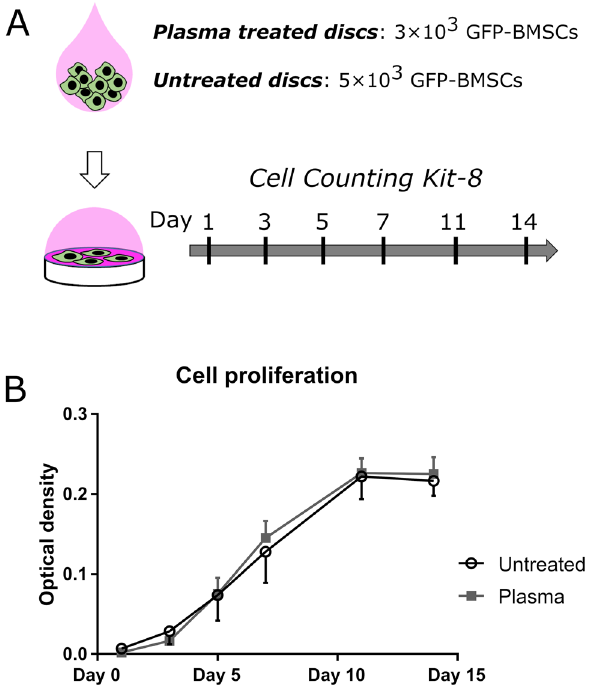
Figure 4. Proliferation assay for rat BMSCs on untreated and plasma-treated β-TCP disks. ( A ) Schematic diagram of the proliferation assay (drawn by using Microsoft PowerPoint 2016). ( B ) Cell proliferation curves for rat BMSCs on untreated (open circles) and plasma-treated (filled squares) β-TCP disks. All measurements were triplicate.